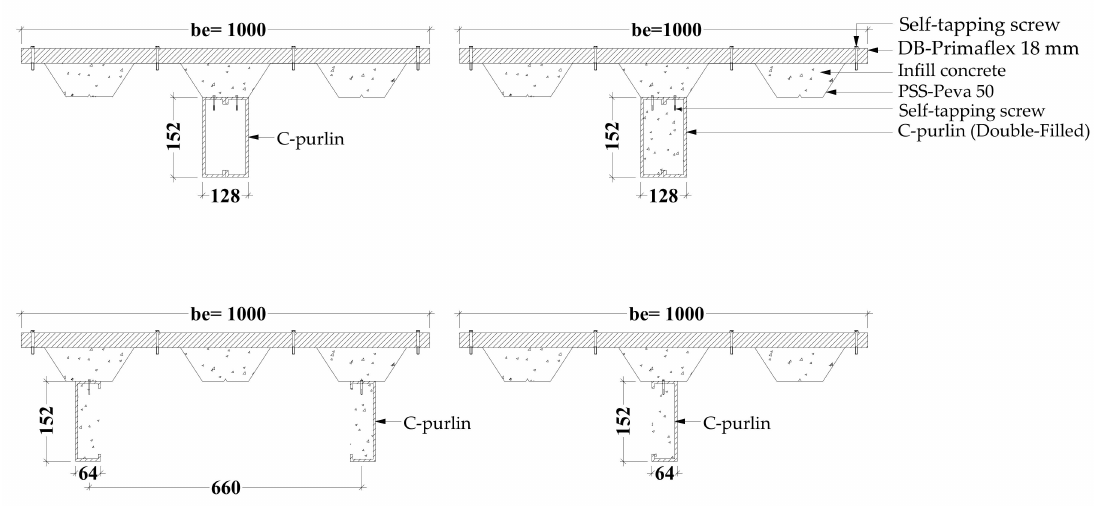
Figure 4. CBPDS cross-section with parallel PSS direction (all dimensions in